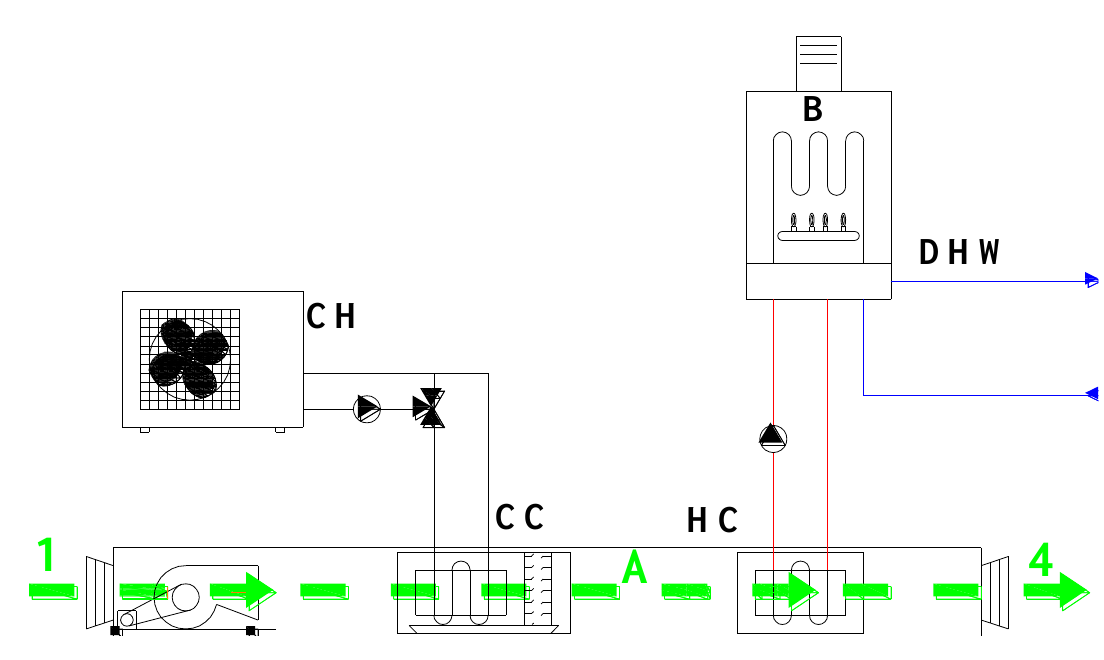
Figure 5. AHU layout for RS (reference